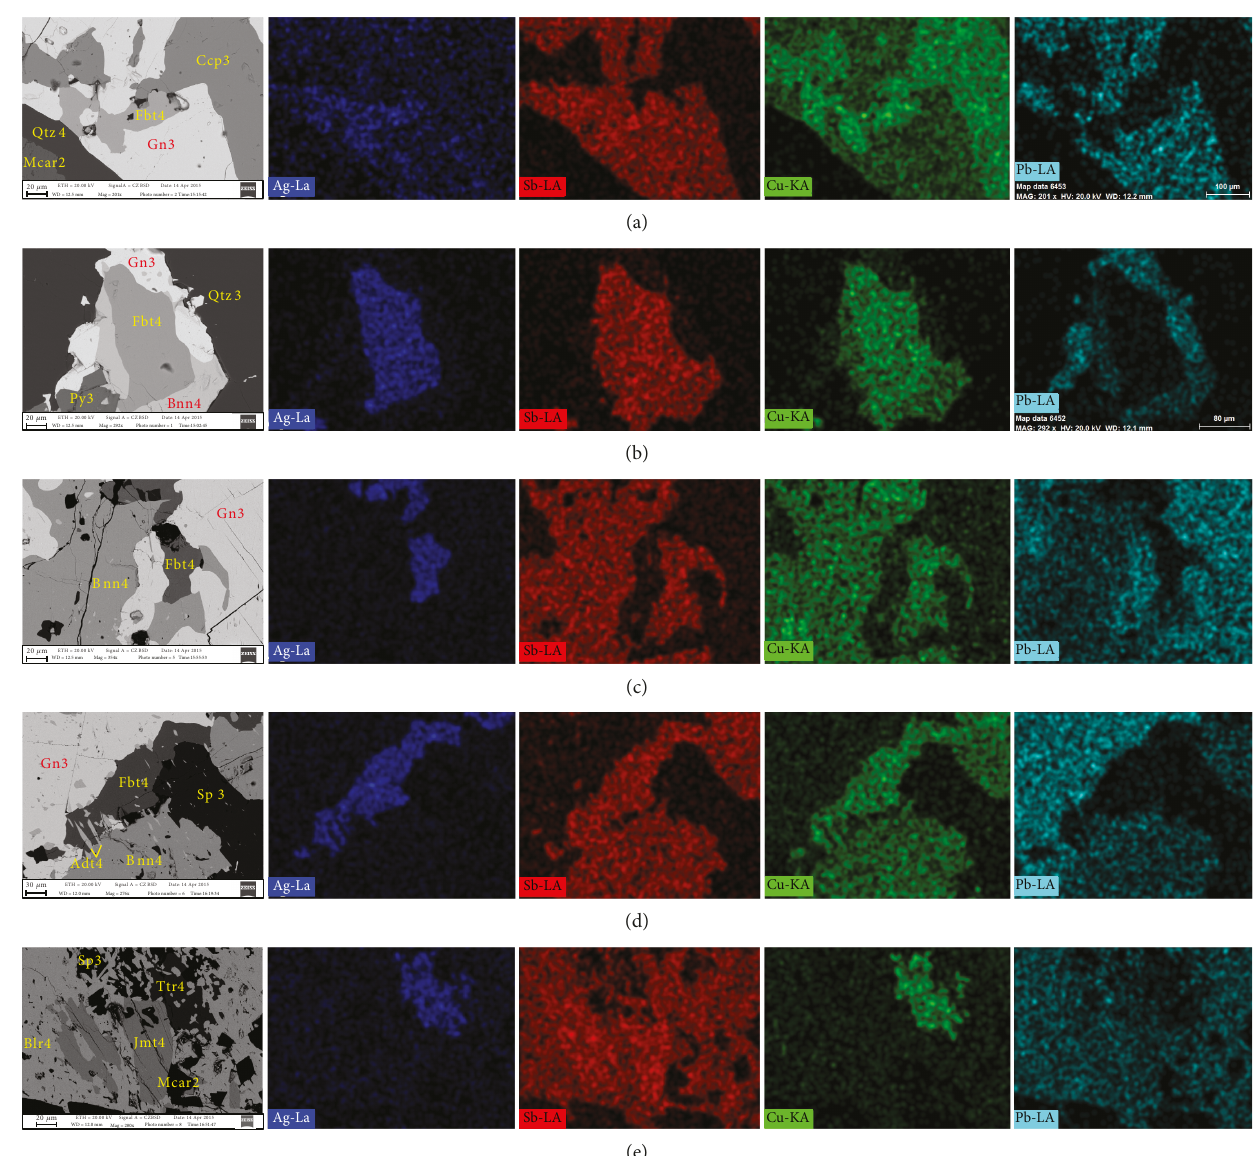
Figure 6: The BSE images for primary Ag-bearing minerals and X-ray mapping images for Ag, Sb, Cu, and Pb elements in the Keyue Sb – Pb – Zn – Ag deposit. Abbreviations are the same as in Figure 4.